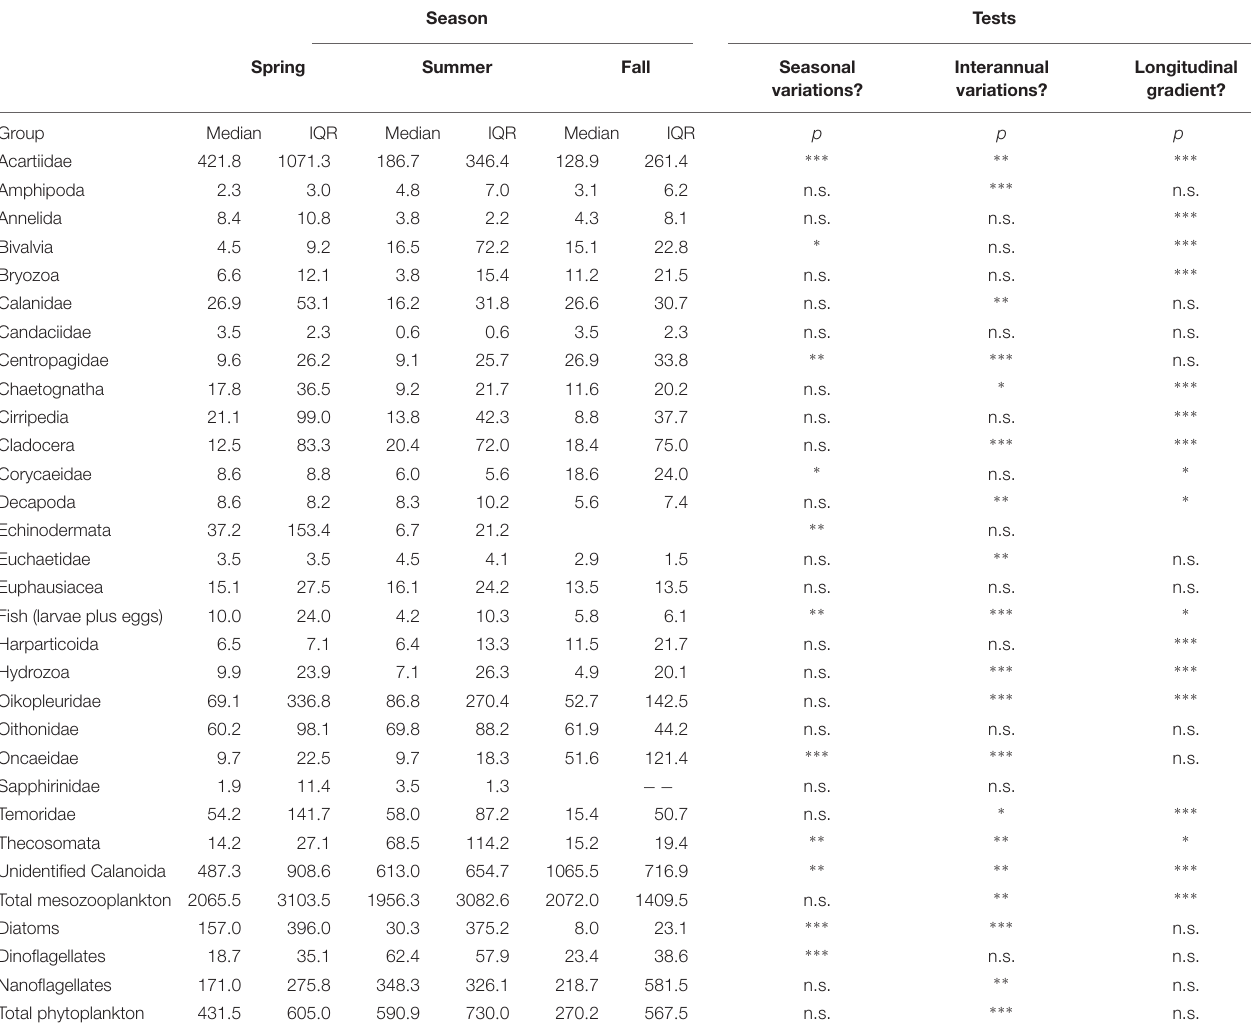
TABLE 1 | Seasonal, inter-annual and longitudinal variations of the median and interquartile ranges (IQR) of the abundance of mesozooplankton and phytoplankton